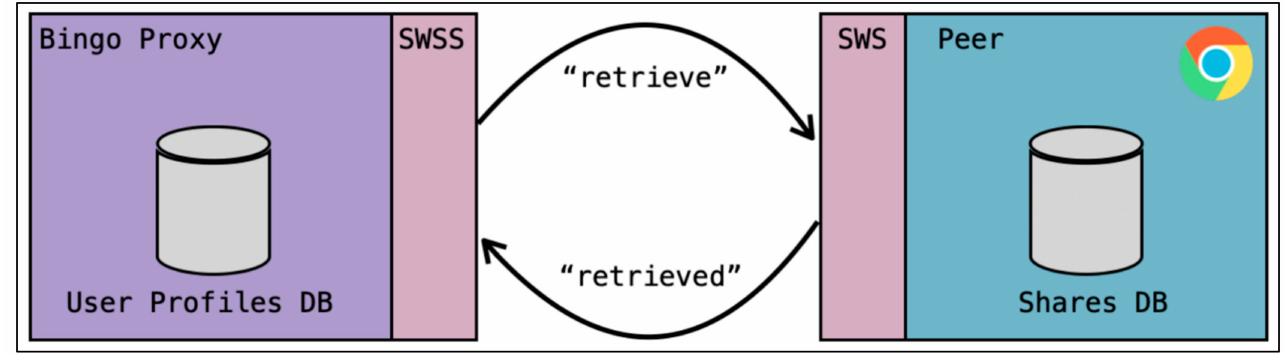
Figure 7. Bingo Chrome communicating with Bingo